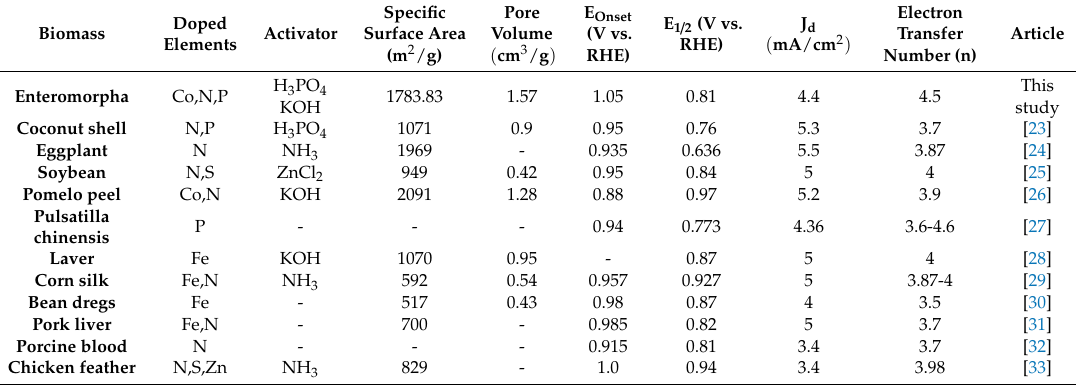
Table 1. ORR catalytic performance of biomass derived carbons doped with various heteroatoms under alkaline conditions.